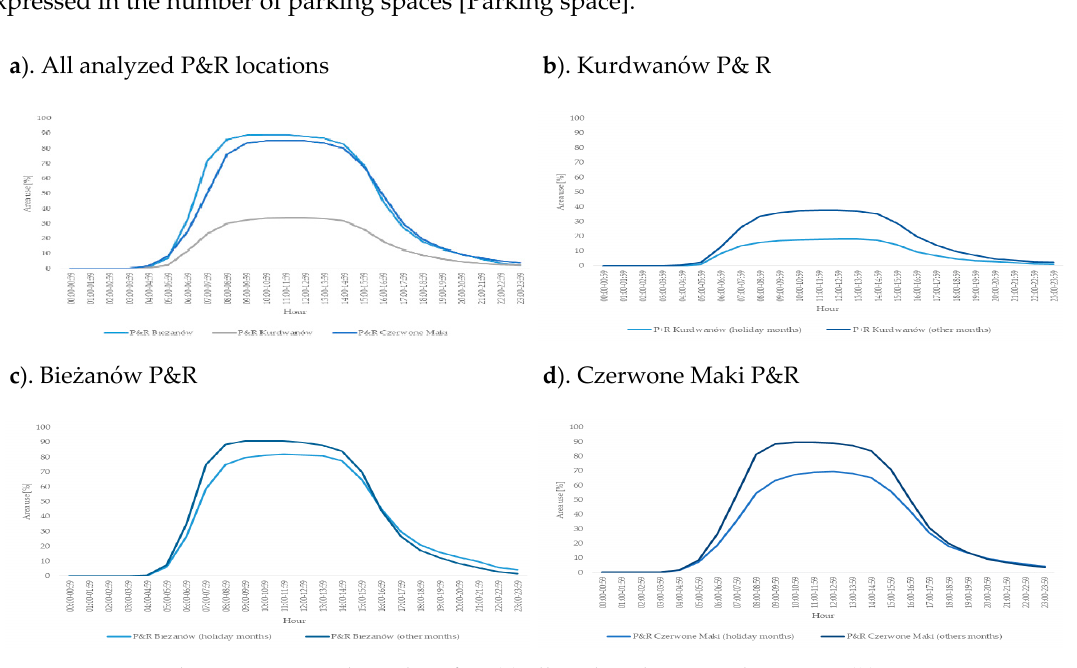
Figure 11. Parking rate on working days for: ( a ) all analyzed P&R parking sites; ( b ) Bie ż anów P&R parking; ( c ) Czerwone Maki P&R parking; ( d ) Kurdwanów P&R parking.